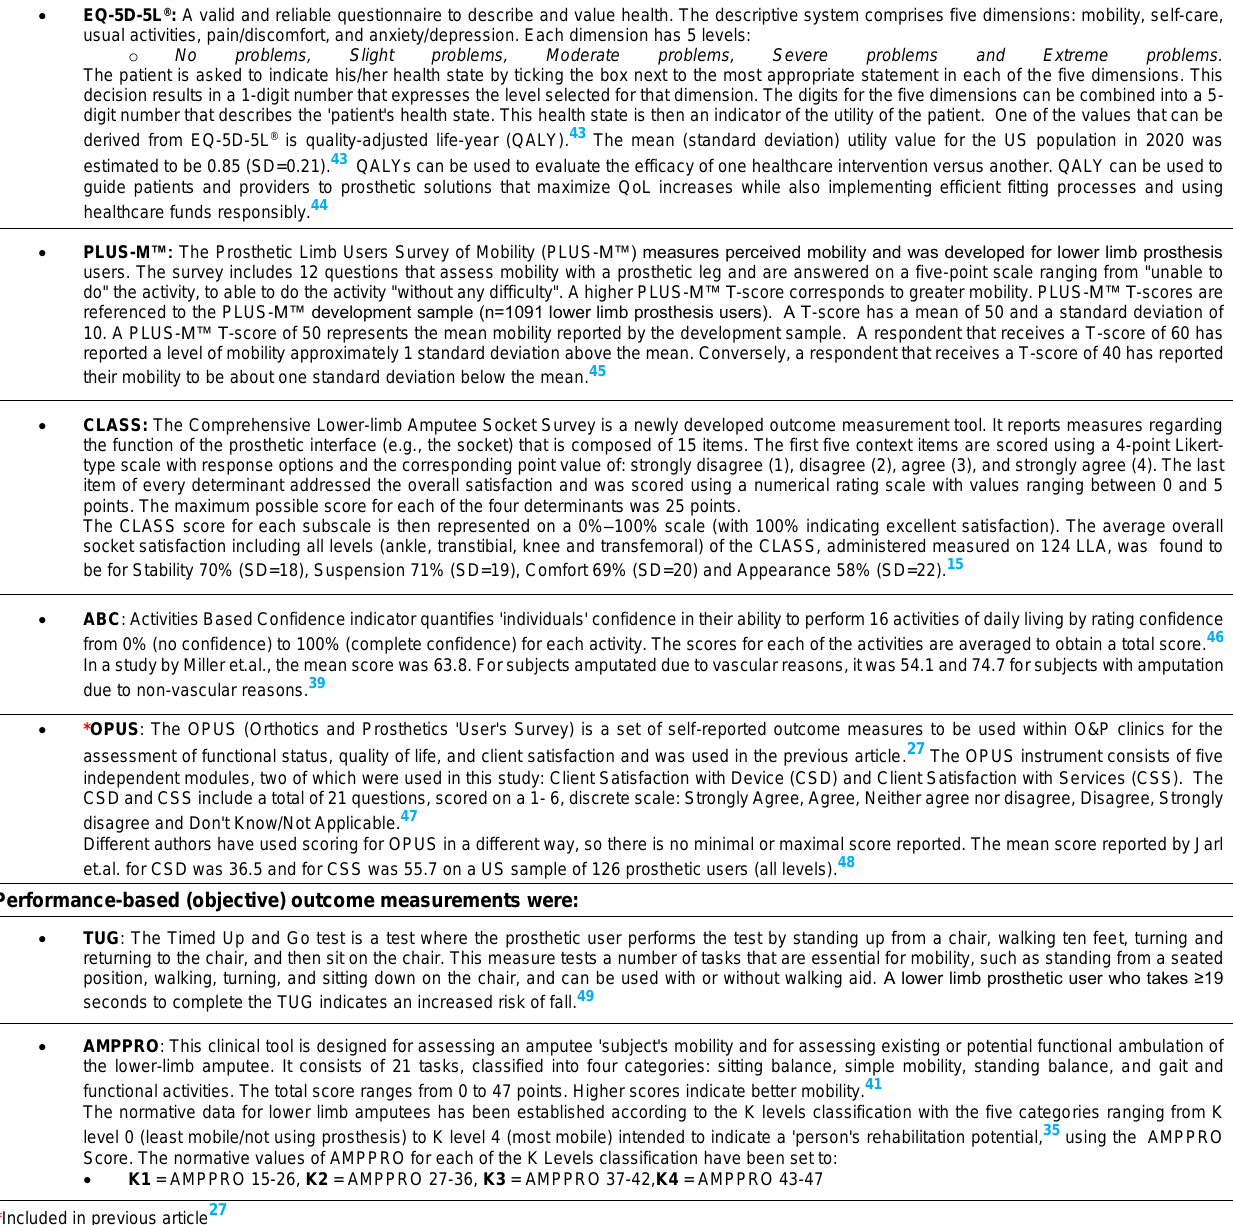
Table 1: Full description of the outcome measures used in this